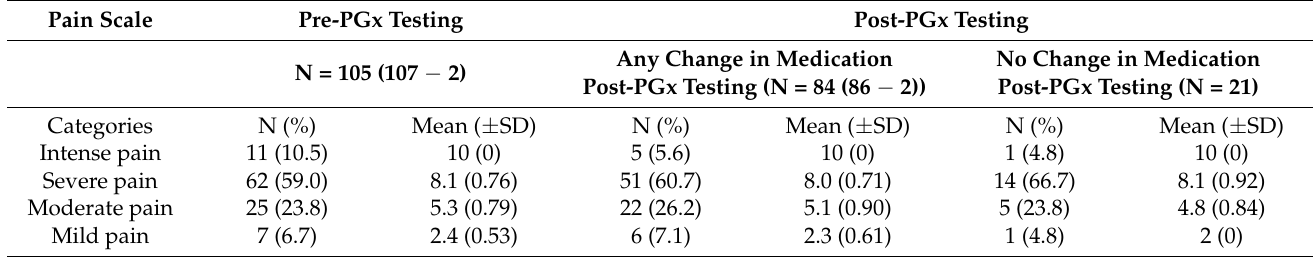
Table 6. Patients’ pain scale pre- and post-pharmacogenomic (PGx) testing, stratified by change in medication post-PGx testing.